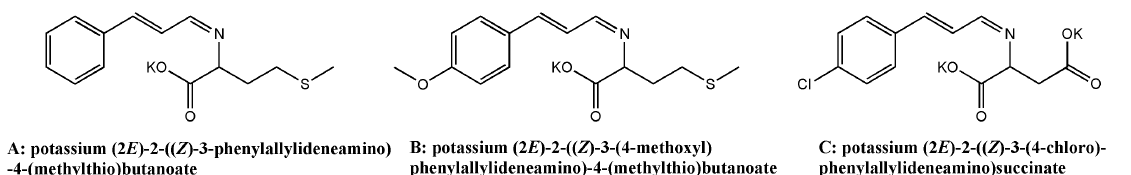
Figure 4. The structures of the screened compounds.